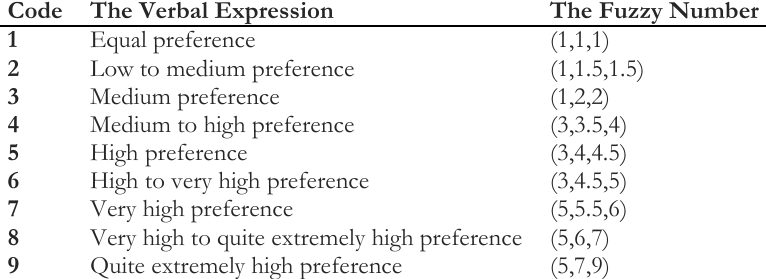
Table 2. The verbal expressions and the fuzzy